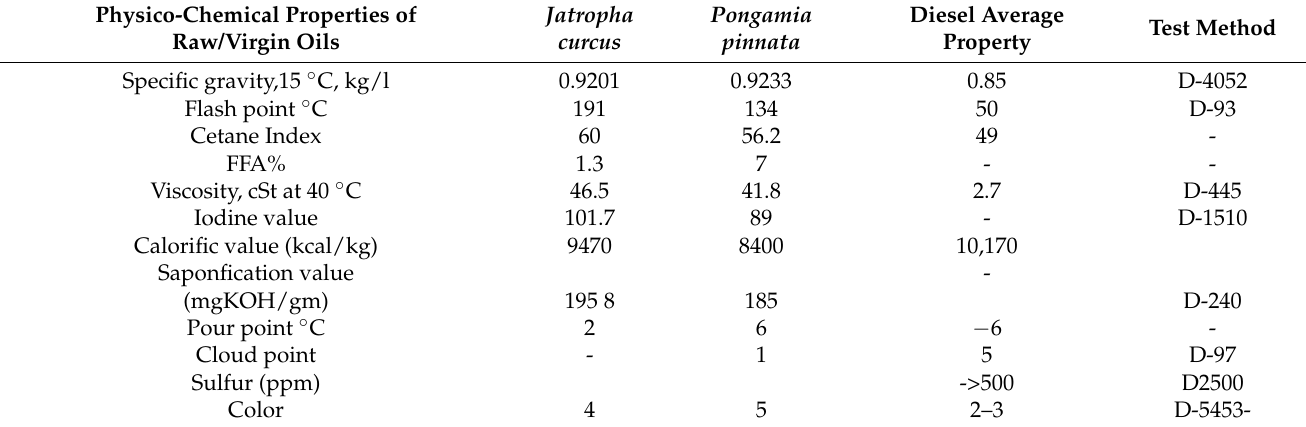
Table 3. Characteristic features of Jatropha and Pongamia raw oil and average property of diesel.